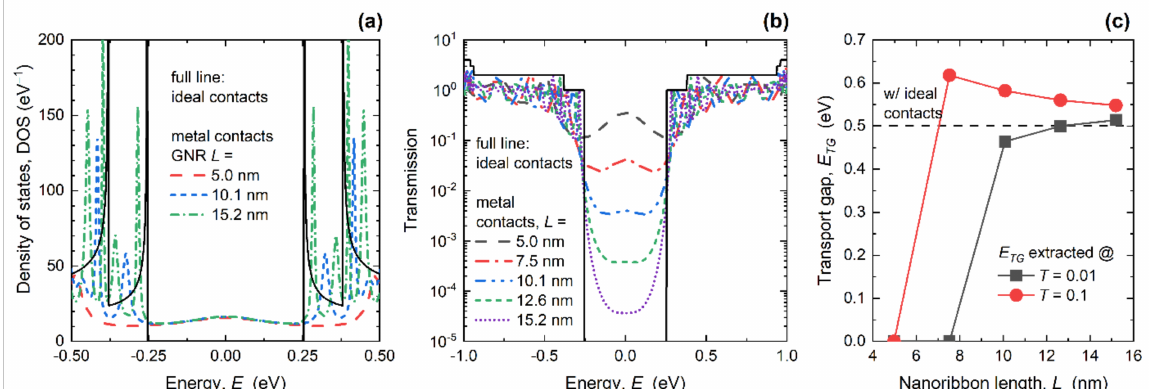
Figure 4. Influence of length downscaling from 15.2 nm to 5.0 nm on ( a ) density of states, ( b ) transmission, and ( c ) the transport gap in GNRs with MCs. In all plots, corresponding results for the IC case are inserted for comparison. W = 2.6